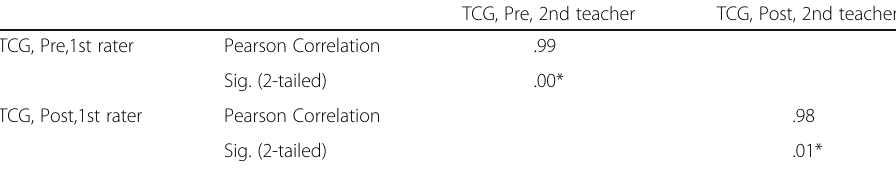
Table 2 Inter-rater reliability of the pretest and posttest scores of the teacher corrective feedback group (TCG) TCG, Pre, 2nd teacher TCG, Post, 2nd teacher TCG, Pre,1st rater Pearson Correlation